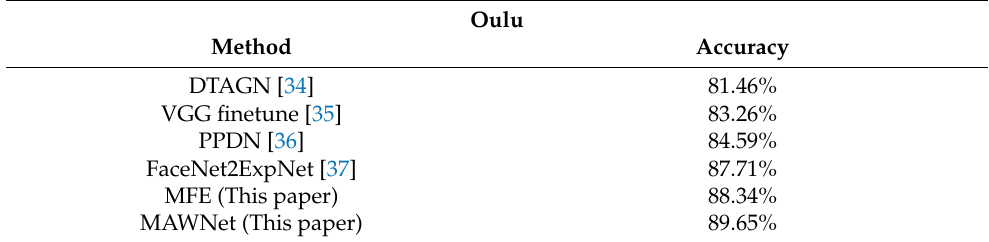
Table 4. Accuracy of different methods on the Oulu dataset.